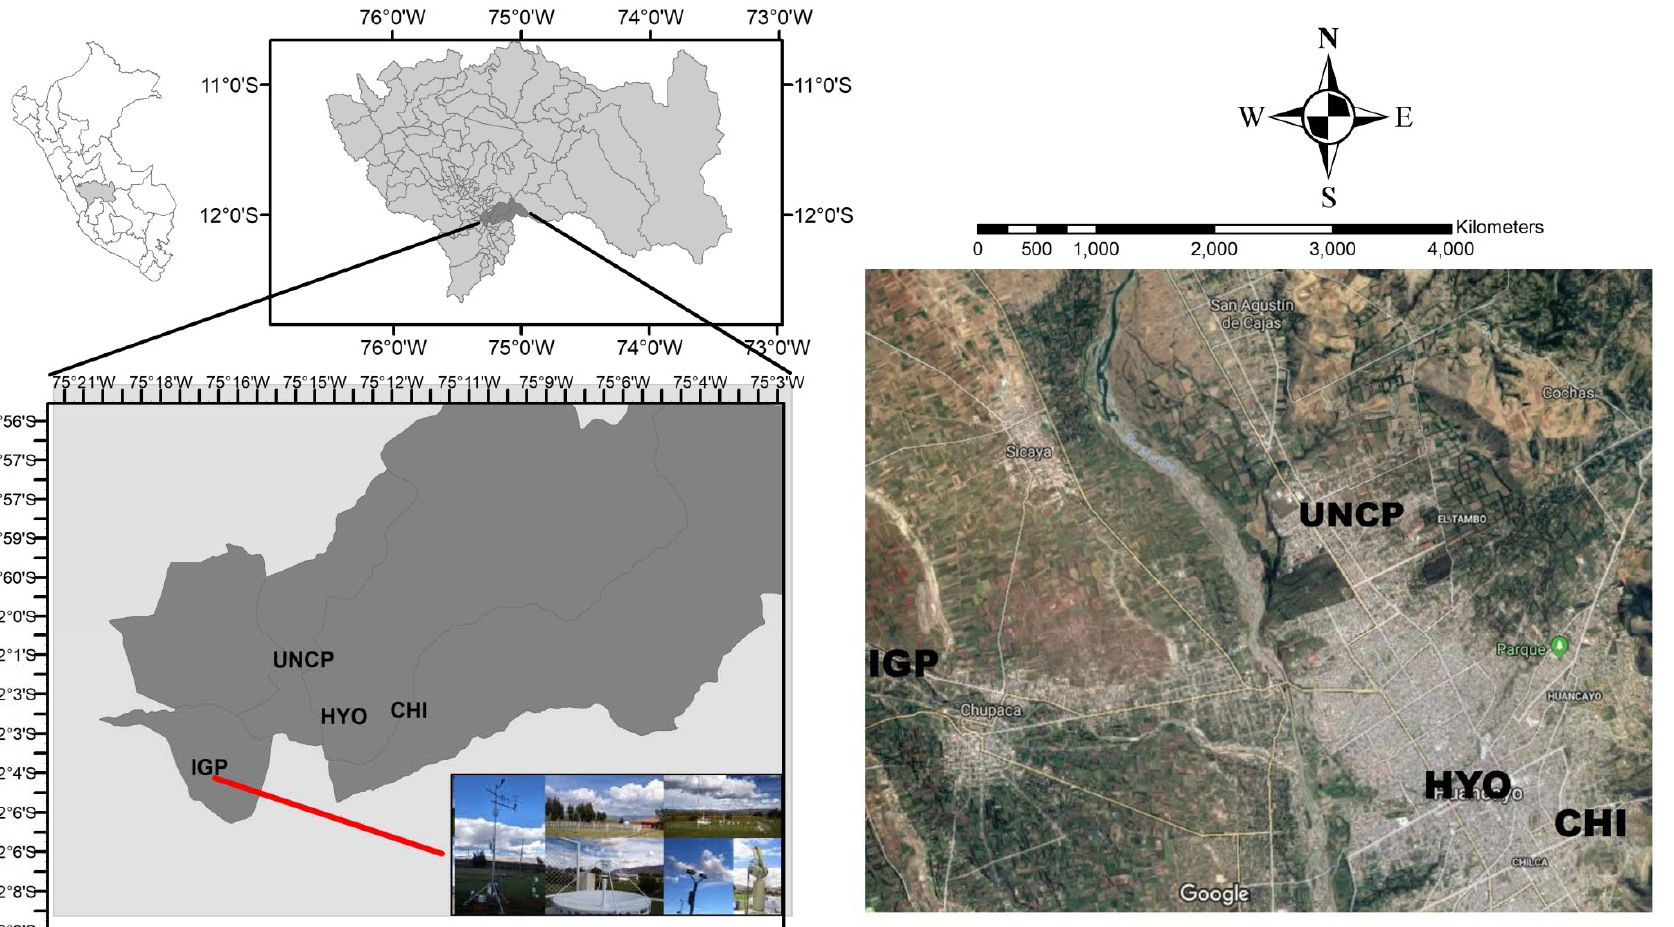
Figure 1. Location of the monitoring stations. The map was prepared with Arc GIS 10.0 software.